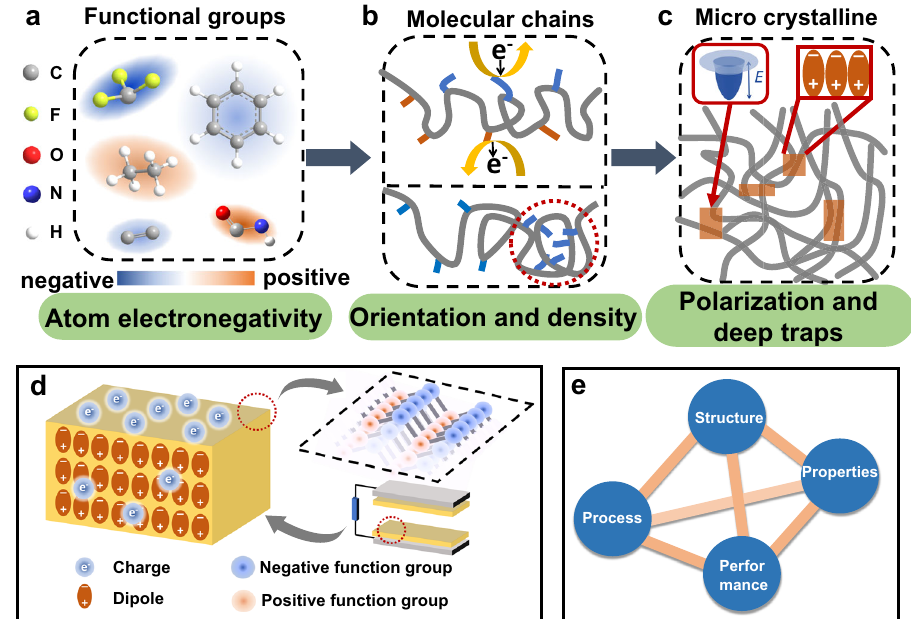
Fig. 6 The key parameters for elevating the electri fi cation performance. In fl uence of a Functional groups ( b ) Molecular chains ( c ) Microcrystalline and d Synergistic effect on contact electri fi cation ability of polymer. e The diagram of the polymer is successfully adjusted through a processing, so as to further change its properties and